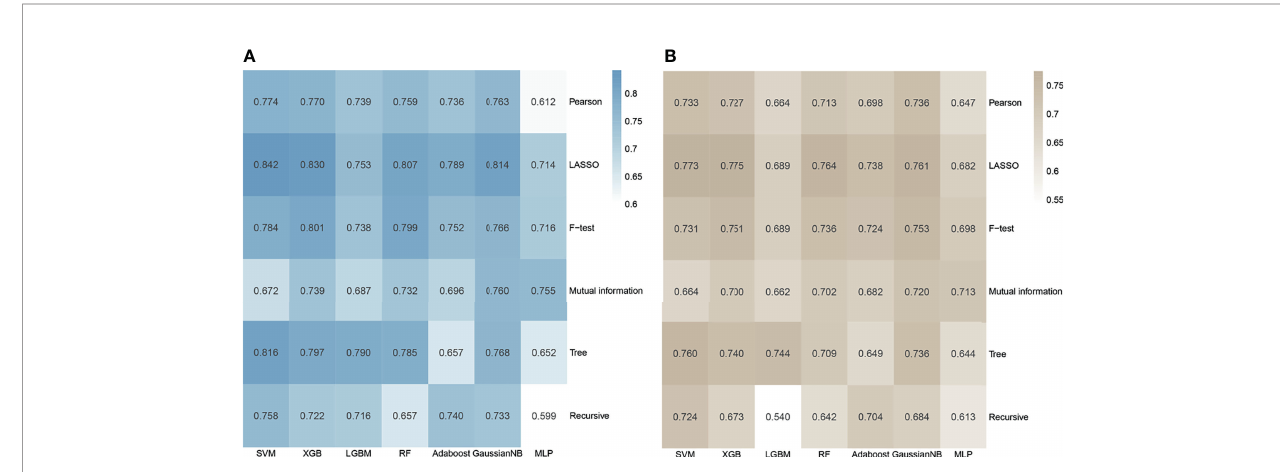
FIGURE 2 | Heatmap of the model performance under different algorithm combinations of feature selection methods (rows) and classi fi cation algorithms (columns). (A) Area under the curve (AUC) values of the 42 models in the cross-validation. (B) Accuracy values of the 42